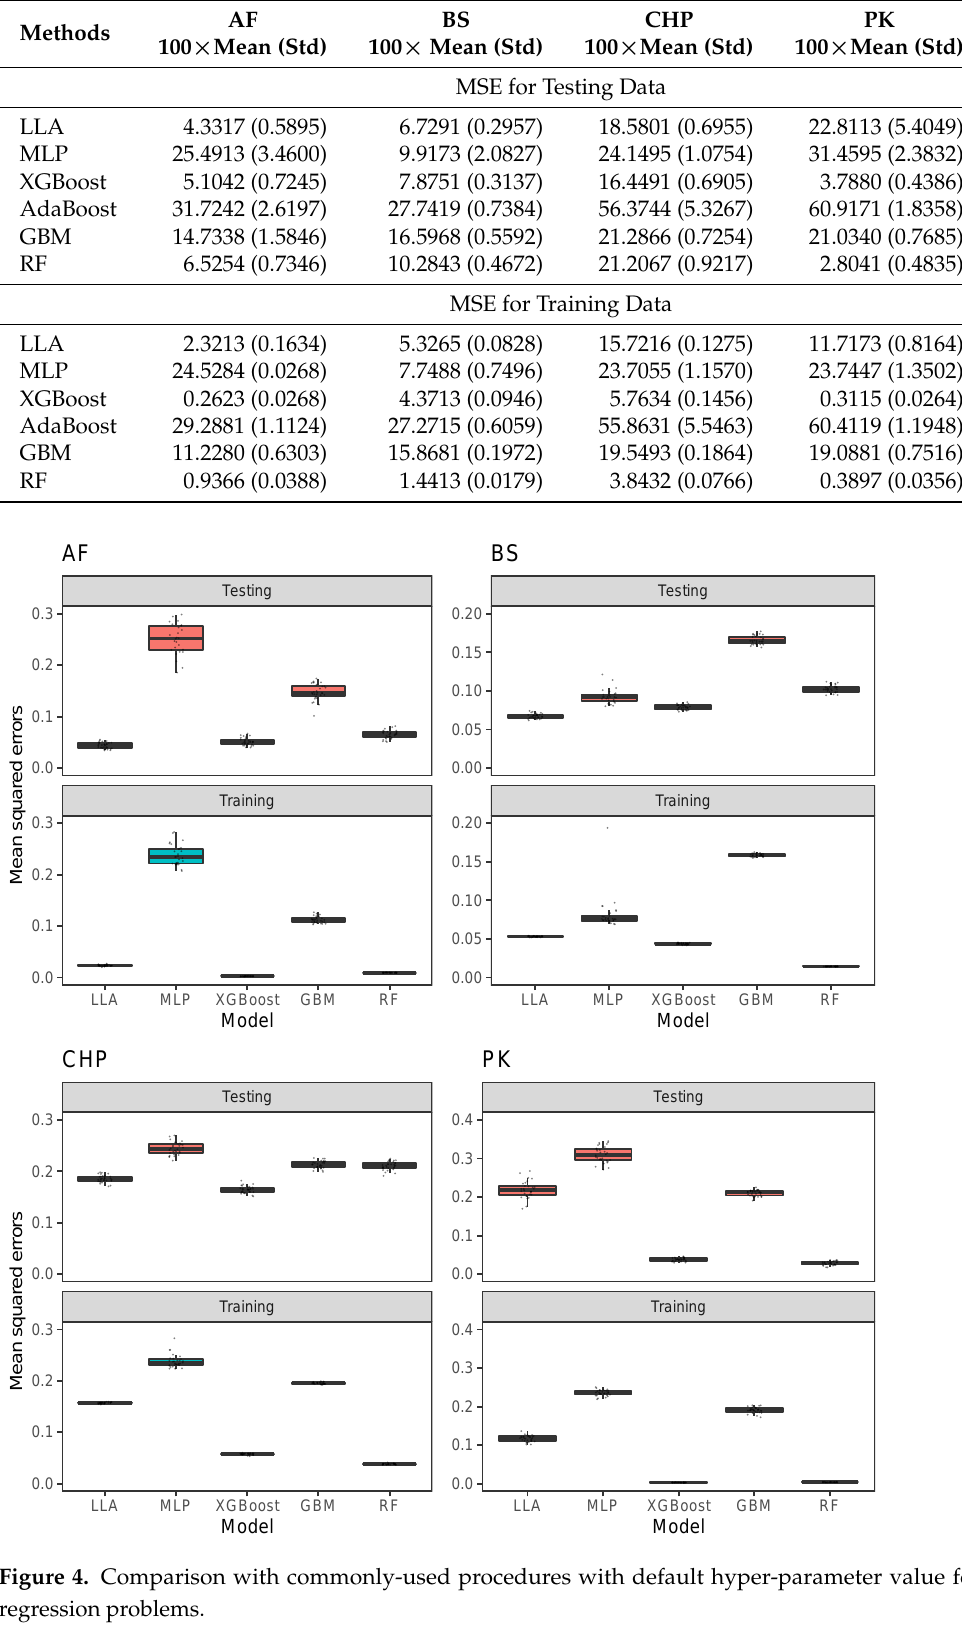
Table 1. Comparison with commonly-used regressors with default hyper-parameter values.